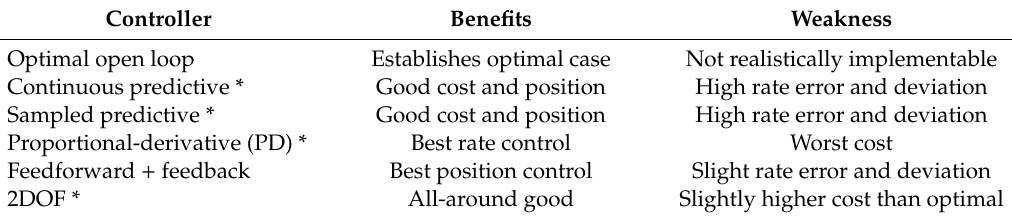
Table 3. Summary 1 of the deterministic